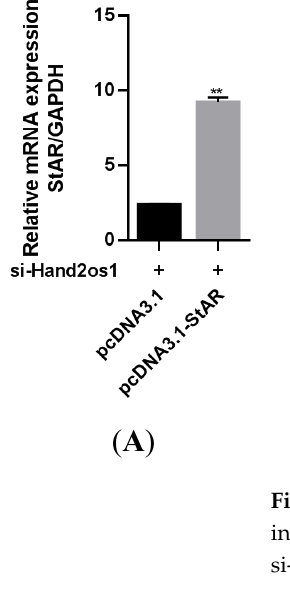
Figure 6. Effects of Hand2os1 on progesterone production in LCs. LCs were isolated from the CL on D4 of pregnancy following transfection with si- Hand2os1 or pcDNA3.1- Hand2os1 for 24 h. Then, ( A ) the concentration of progesterone in the culture supernatants was determined by ELISA, and the expression levels of the steroidogenic enzyme ( B ) StAR and ( C ) Cyp11a1 genes were analyzed by qRT-PCR. GAPDH was used as the reference gene for normalization. The data represent the mean ± SEM from three independent experiments. * p < 0.05, ** p < 0.01 compared with si-NC group, and different number of asterisks on bars indicate statistically significant differences ( p < 0.05). To verify the mechanism underlying Hand2os1 regulation of progesterone synthesis through steroidogenic enzymes, we constructed a StAR overexpression vector and used it to transfect primary LCs from Hand2os1 -silenced mice. As shown in Figure 7A,B, StAR overexpression did not change Hand2os1 expression in mouse primary LCs, but significantly upregulated the mRNA expression of StAR inhibited by Hand2os1 . Importantly, overex- pression of StAR significantly increased the progesterone production that was inhibited by si- Hand2os1 in mouse primary LCs (Figure 7C, p < 0.05).